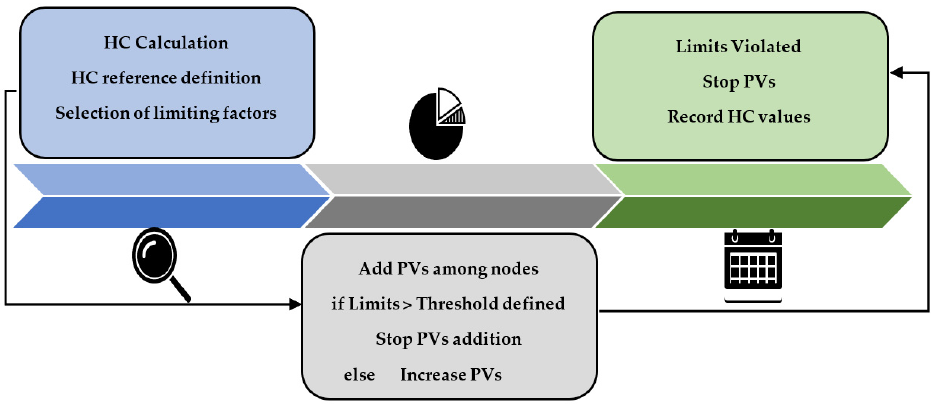
Figure 1. General methodology for hosting capacity (HC) determination .